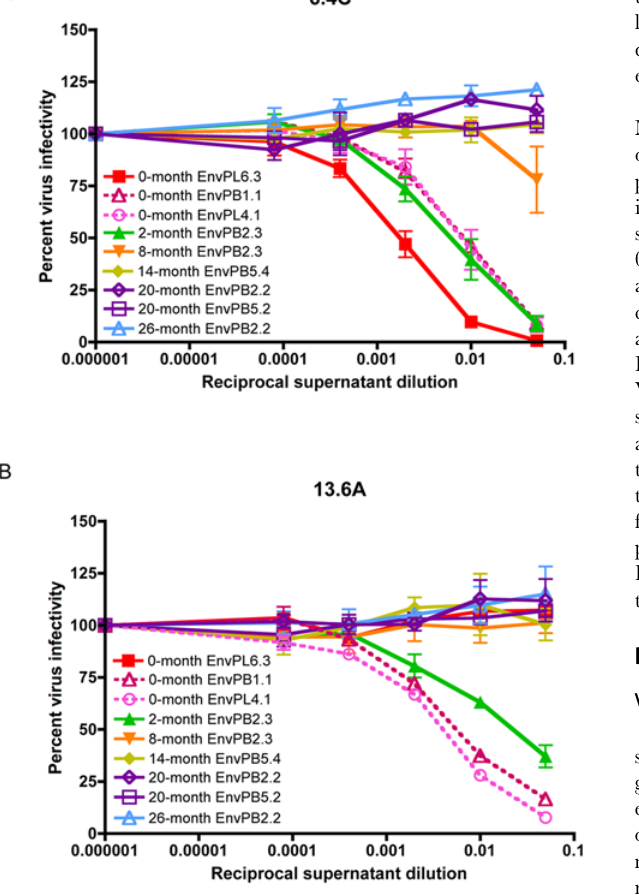
Figure 5. Neutralization profile of 205F Envs by autologous monoclonal antibody-containing supernatants from B cell hybridomas 6.4C and 13.6A. Neutralization activity of 6.4C (A) and 13.6A (B) B cell hybridoma supernatant was evaluated against pseudoviruses expressing autologous 205F Envs. Three different 0- months Envs are shown along with the longitudinal panel of Envs. Percent virus infectivity is plotted against the log10 of the reciprocal dilution of hybridoma culture supernatant in each graph. Error bars represent the standard deviation of at least two independent experiments using duplicate wells. 0-month EnvPB1.1 was used to screen the hybridomas for neutralization activity. B cell hybridomas from 205F were generated at 49-months